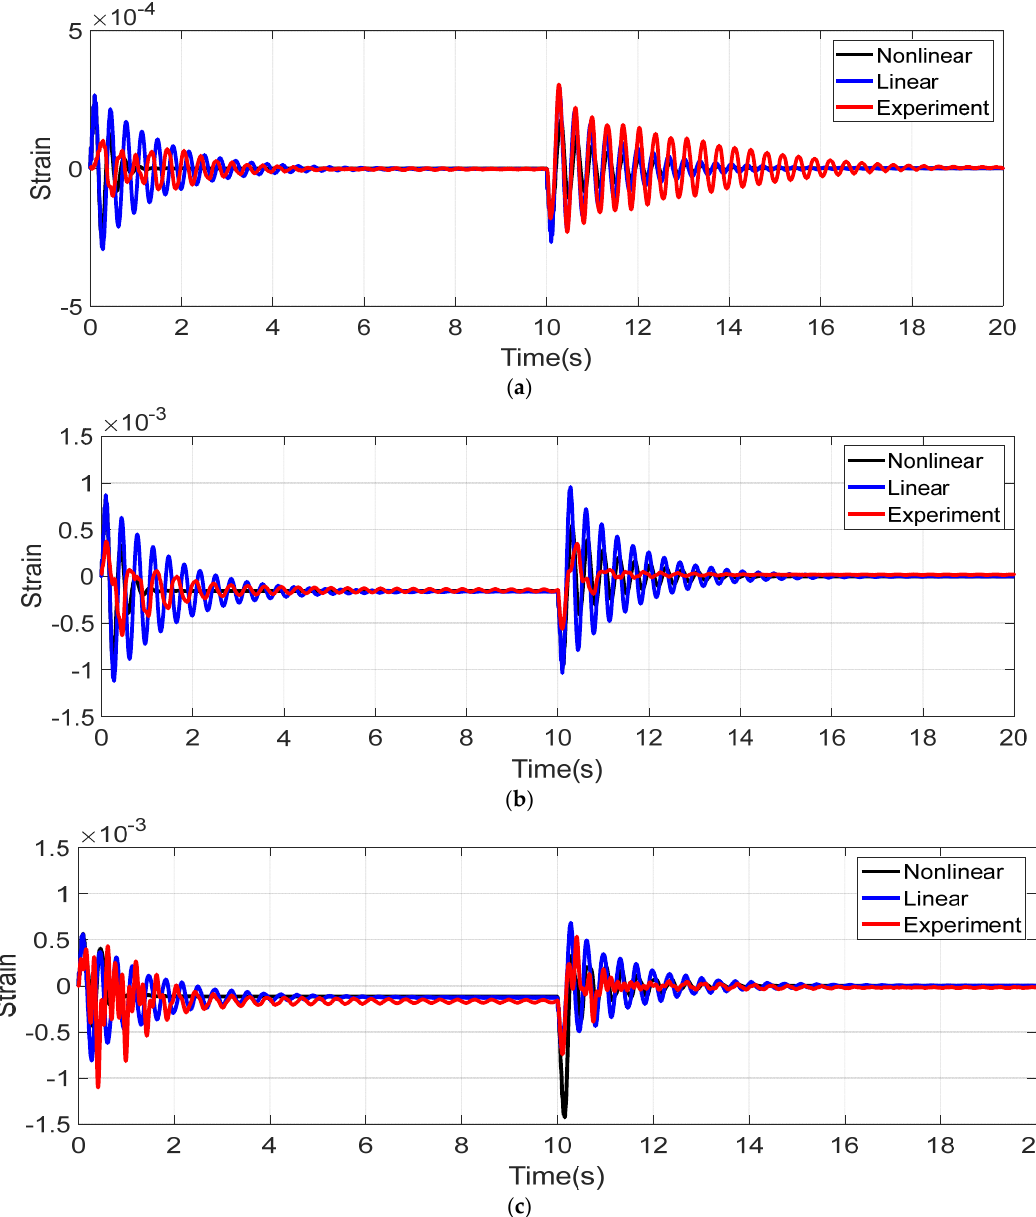
Figure 6. Validation of linearized model from strain data. ( a ) Torsion, ( b ) Link 1 in plane, ( c ) Link 2 in plane.